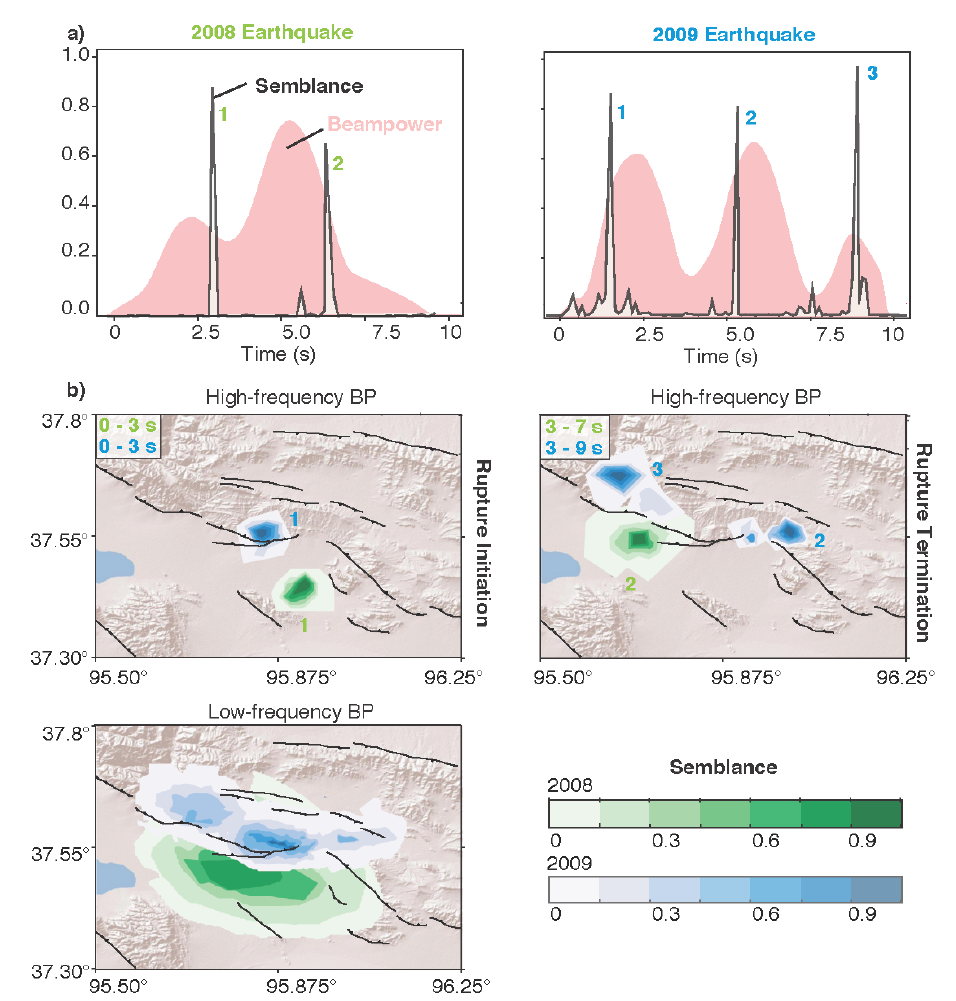
Figure 4. Seismic back-projection for the 10 November 2008 and the 28 August 2009 Haixi earthquakes. ( a ) P wave beampower (filled red curve) and maximum semblance from both LF and HF emissions (white filled curve) as a function of time for the 2008 (left) and 2009 (right) earthquakes. ( b ) Back-projected stack amplitudes shown for given time intervals and grid depths for the two earthquakes (green: 2008, blue: 2009) with warm colours being associated with higher semblance. Semblance peaks are numbered 1, 2, and,